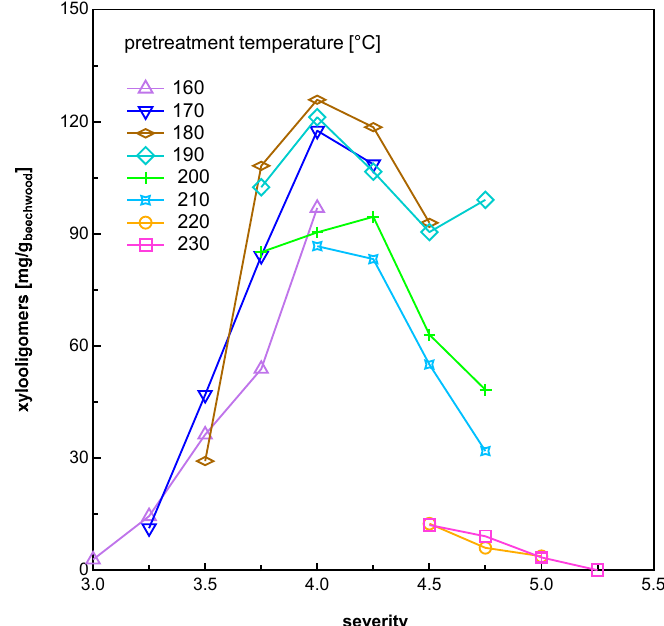
Figure 1. Release of soluble xylooligomers during steam explosion pretreatment. Shown are the amounts of soluble xylooligomers that are released into the prehydrolyzate during steam explosion pretreatment as function of the pretreatment severity and temperature.